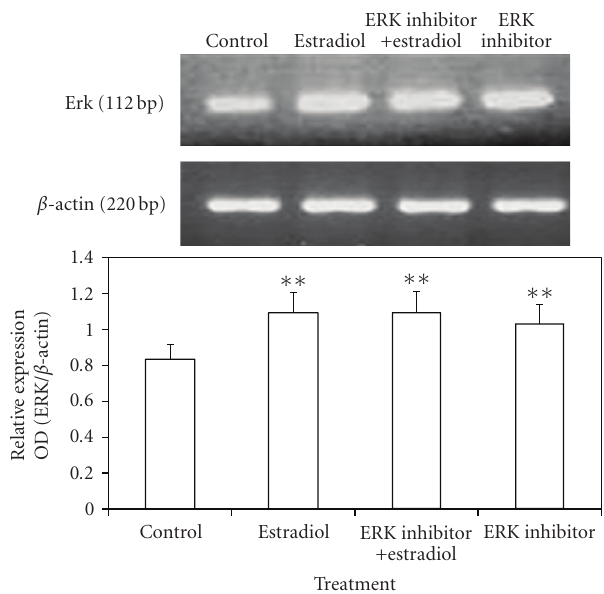
Figure 2: ERK-like expression in Taenia crassiceps . A single band of approximately 112 bp corresponding to ERK was detected in all in vitro treated cysticerci. Unexpectedly, either 17 β -estradiol or ERK inhibitor treatment significantly induced ERK-like expression, related to control cysticerci. β -actin was used as control gene of constitutive expression. Optical densitometry was performed on 2% agarose gel from six independent experiments. Control = Parasites treated with the vehicle where hormone and inhibitors were dissolved; ∗∗ P < .